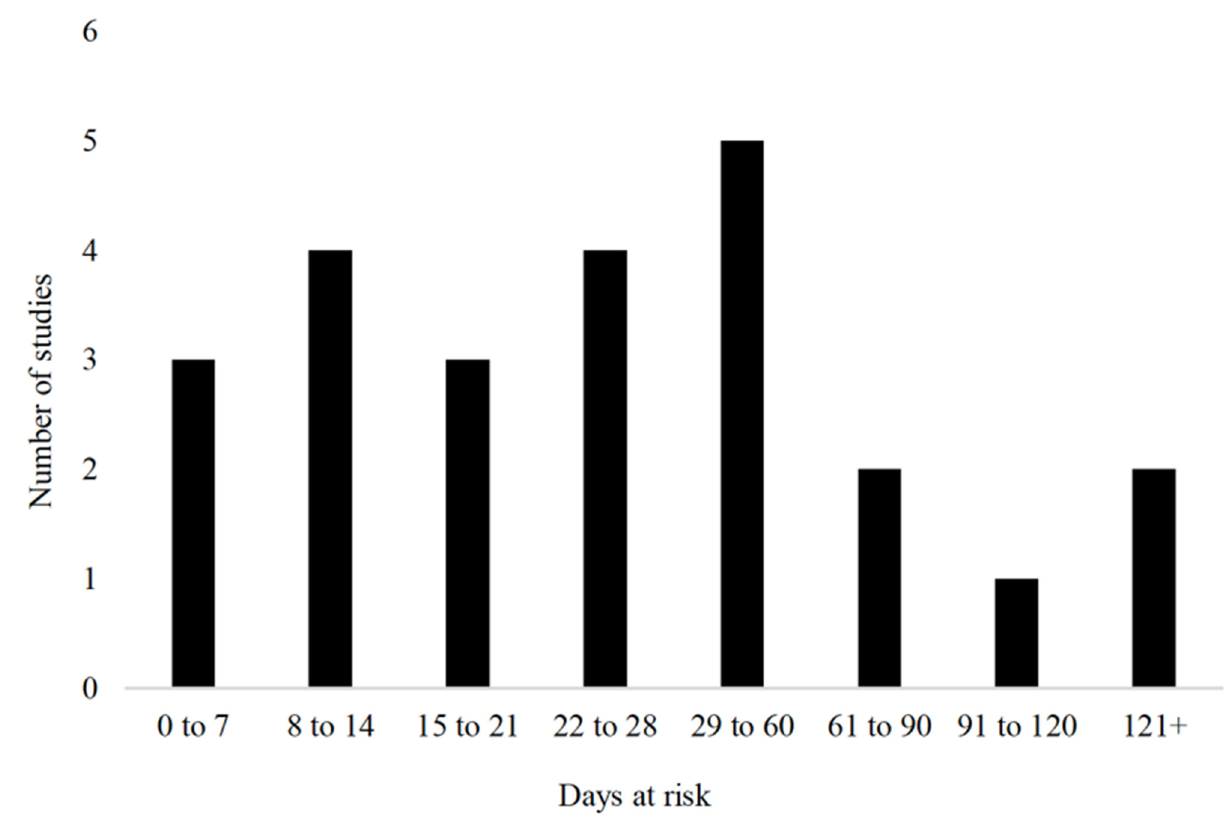
Figure 3. Time at risk (days) for development of outcomes in clinical trials ( n = 24) included in the scoping review of literature surrounding umbilical health in intensively raised